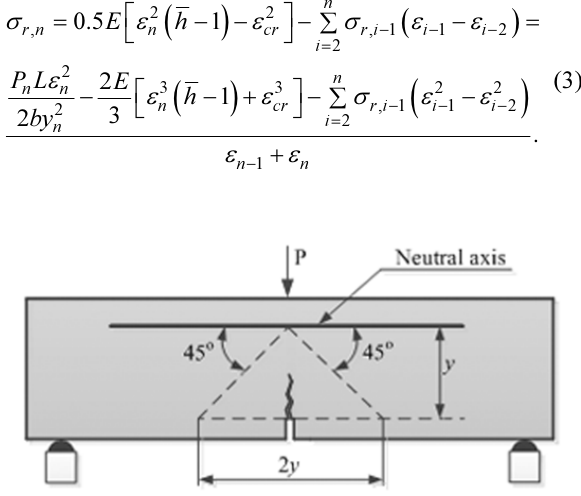
Fig. 6. Definition of the influence length for a beam